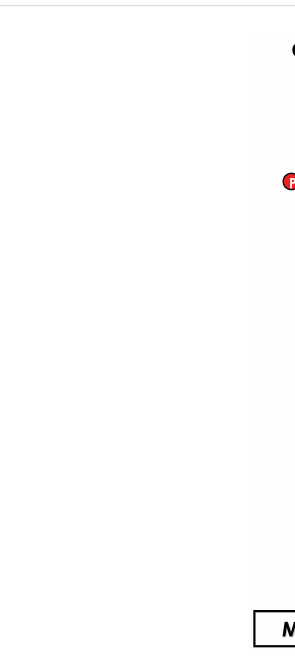
FIGURE 3 Activation of autophagy during macrophage differentiation. Activation of CSF1R leads to an increase in level of the purinergic receptor P2RY6 at the surface of differentiating monocytes. P2RY6 triggers PLC b activation, increase in calcium level and a cascade of kinase activation CAMKK2>ULK1 that culminate in the induction of